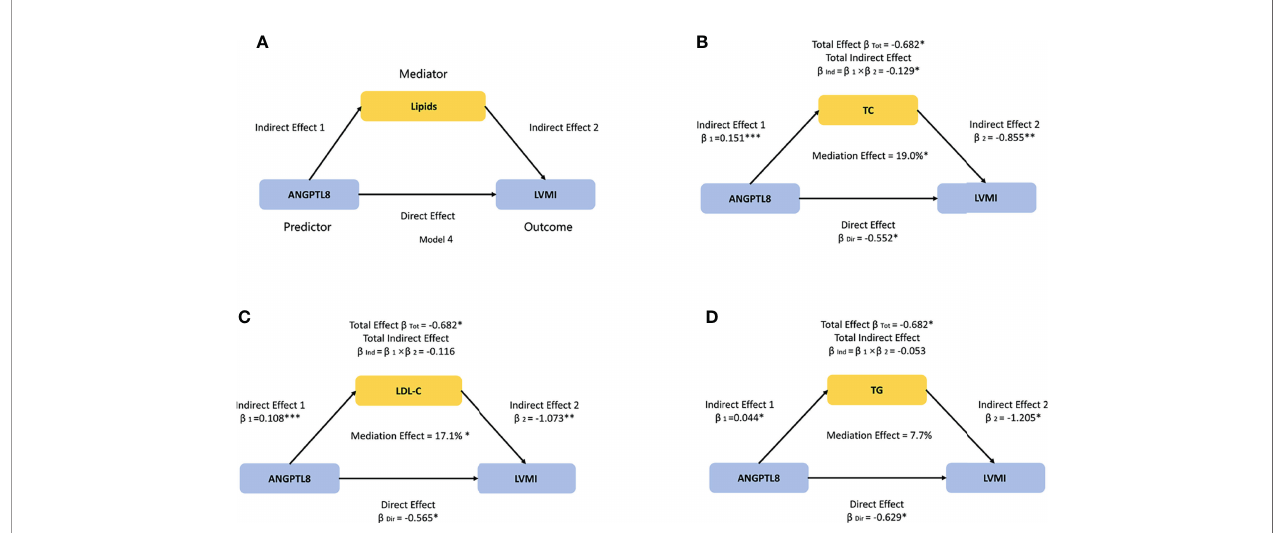
FIGURE 1 | The model used to evaluate the mediation effects of lipids on ANGPTL8-LVMI association. (A) We hypothesized that ANGPTL8 may indirectly affect left ventricular mass index (LVMI) by regulating lipids metabolism including total cholesterol (TC), low-density lipoprotein cholesterol (LDL-C), and triglyceride (TG). (B) TC signi fi cantly mediated 19.0% of the effect of ANGPTL8 on LVMI. (C) LDL-C signi fi cantly mediated 17.1% of the effect of ANGPTL8 on LVMI. (D) The effect that was mediated by TG was 7.7%, although it was not signi fi cant. Mediation effects were adjusted for age, sex, body mass index, and systolic blood pressure; per z-score increment of ln-ANGPTL8. b = standardized regression coef fi cient; b 1 = indirect effect 1; b 2 = indirect effect 2; b Ind = total indirect effect; b Dir = direct effect; b Tot = total effect; Data based on 5000 bootstrap samples. * P < 0.05; ** P < 0.01; *** P <